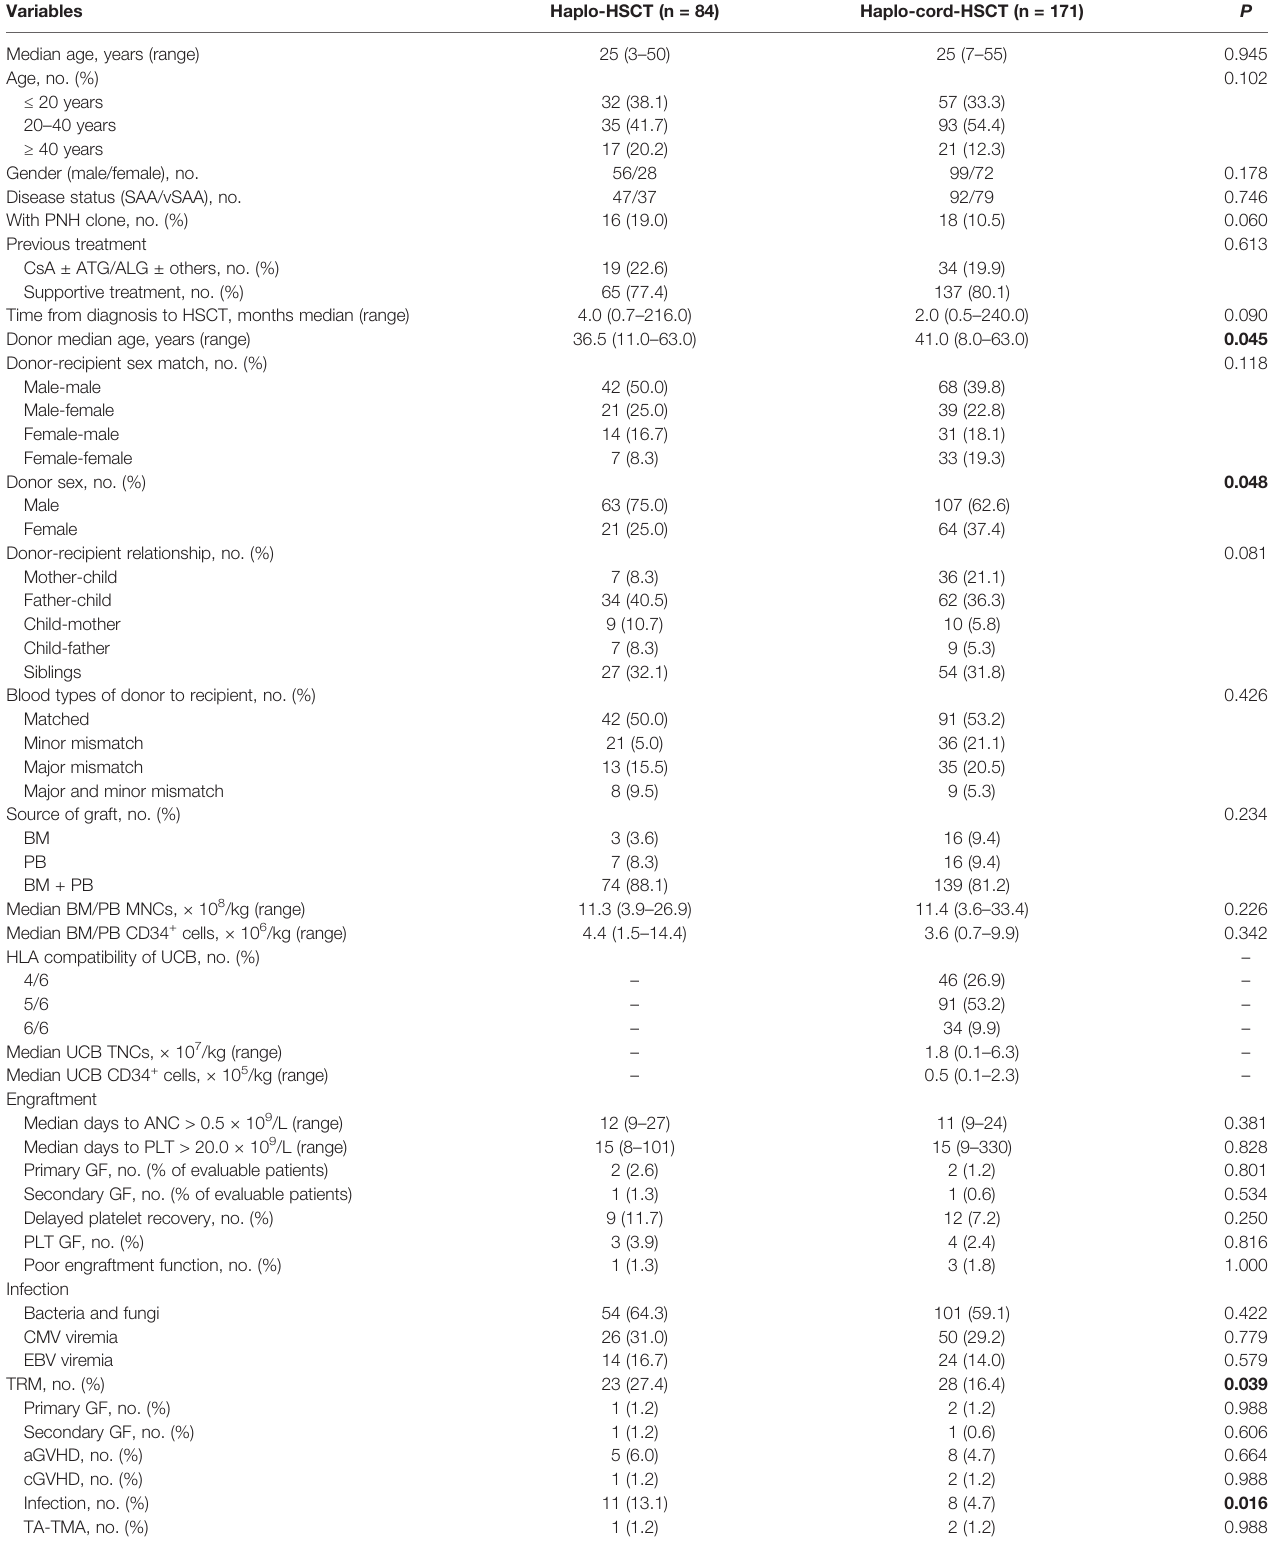
TABLE 1 | Patient and donor (graft) characteristics and clinical outcomes between the two